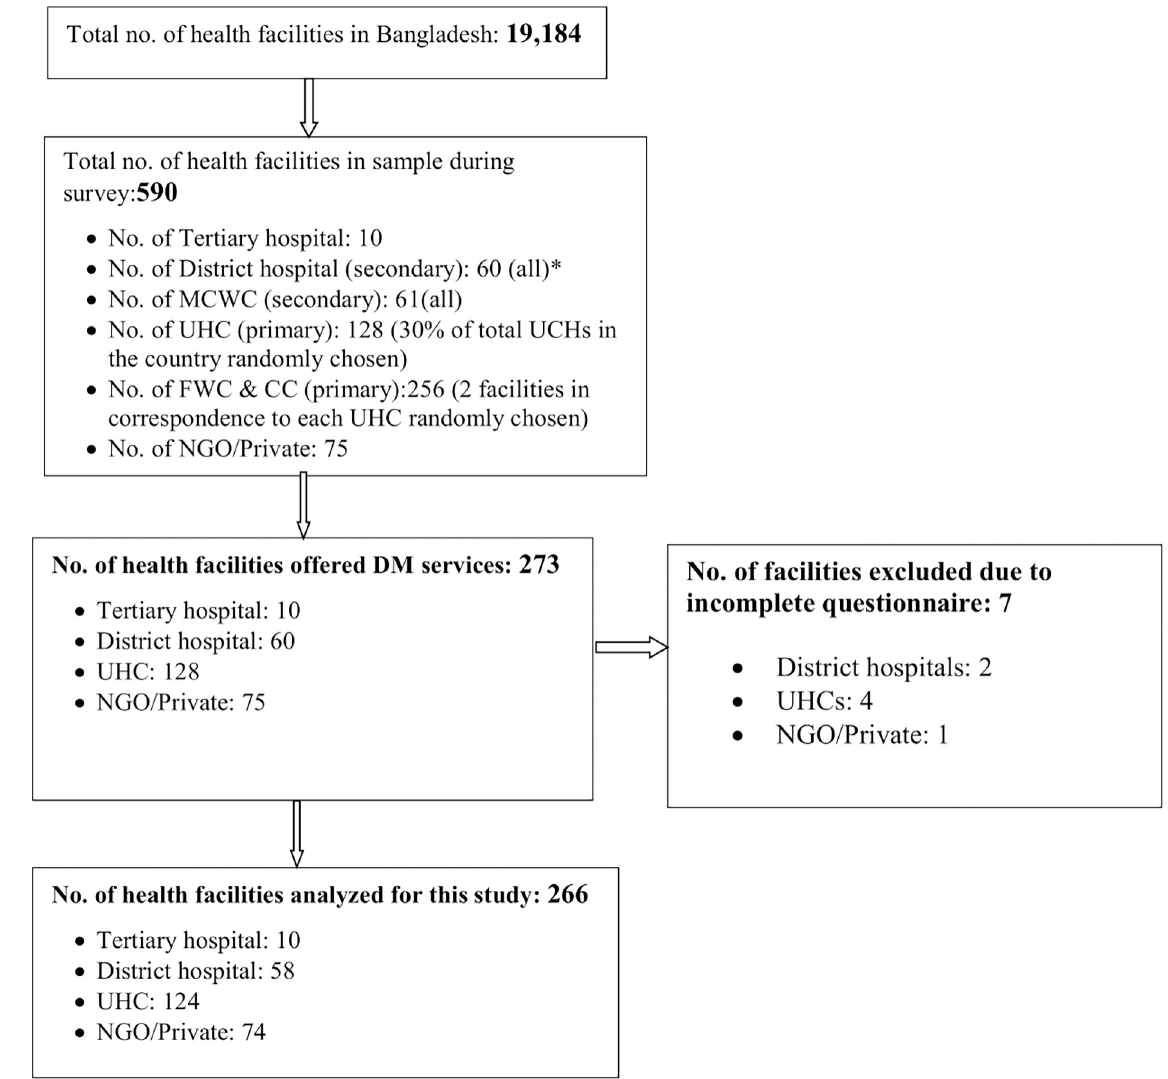
Fig 1. Sampling and study inclusion flow chart. [UHC: Upazila Health Complex, NGO: Non-Government Organization. � rest of the district hospitals had been converted to medical college hospital (tertiary facilities)].